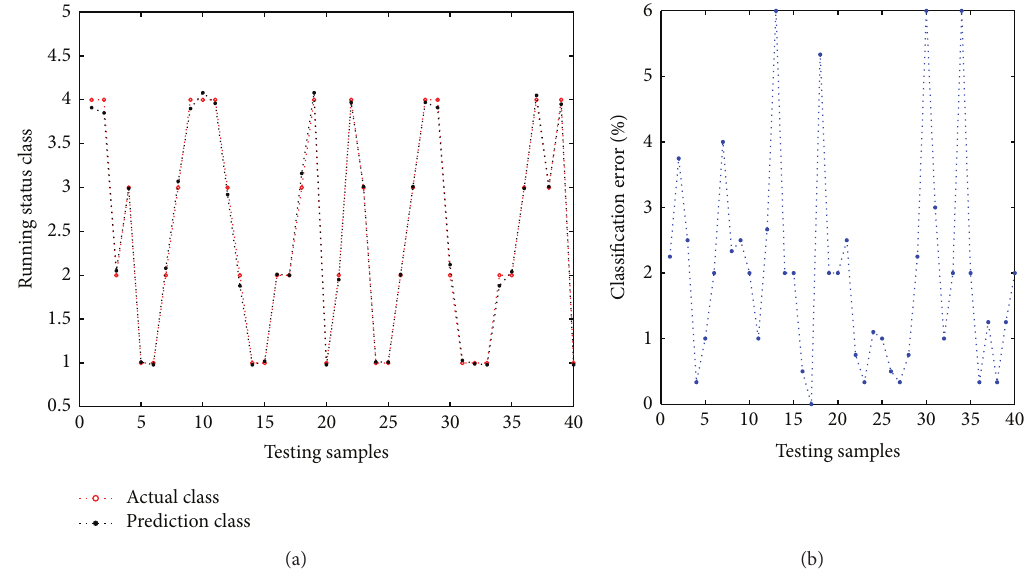
Figure 9: The contrast of prediction class and actual